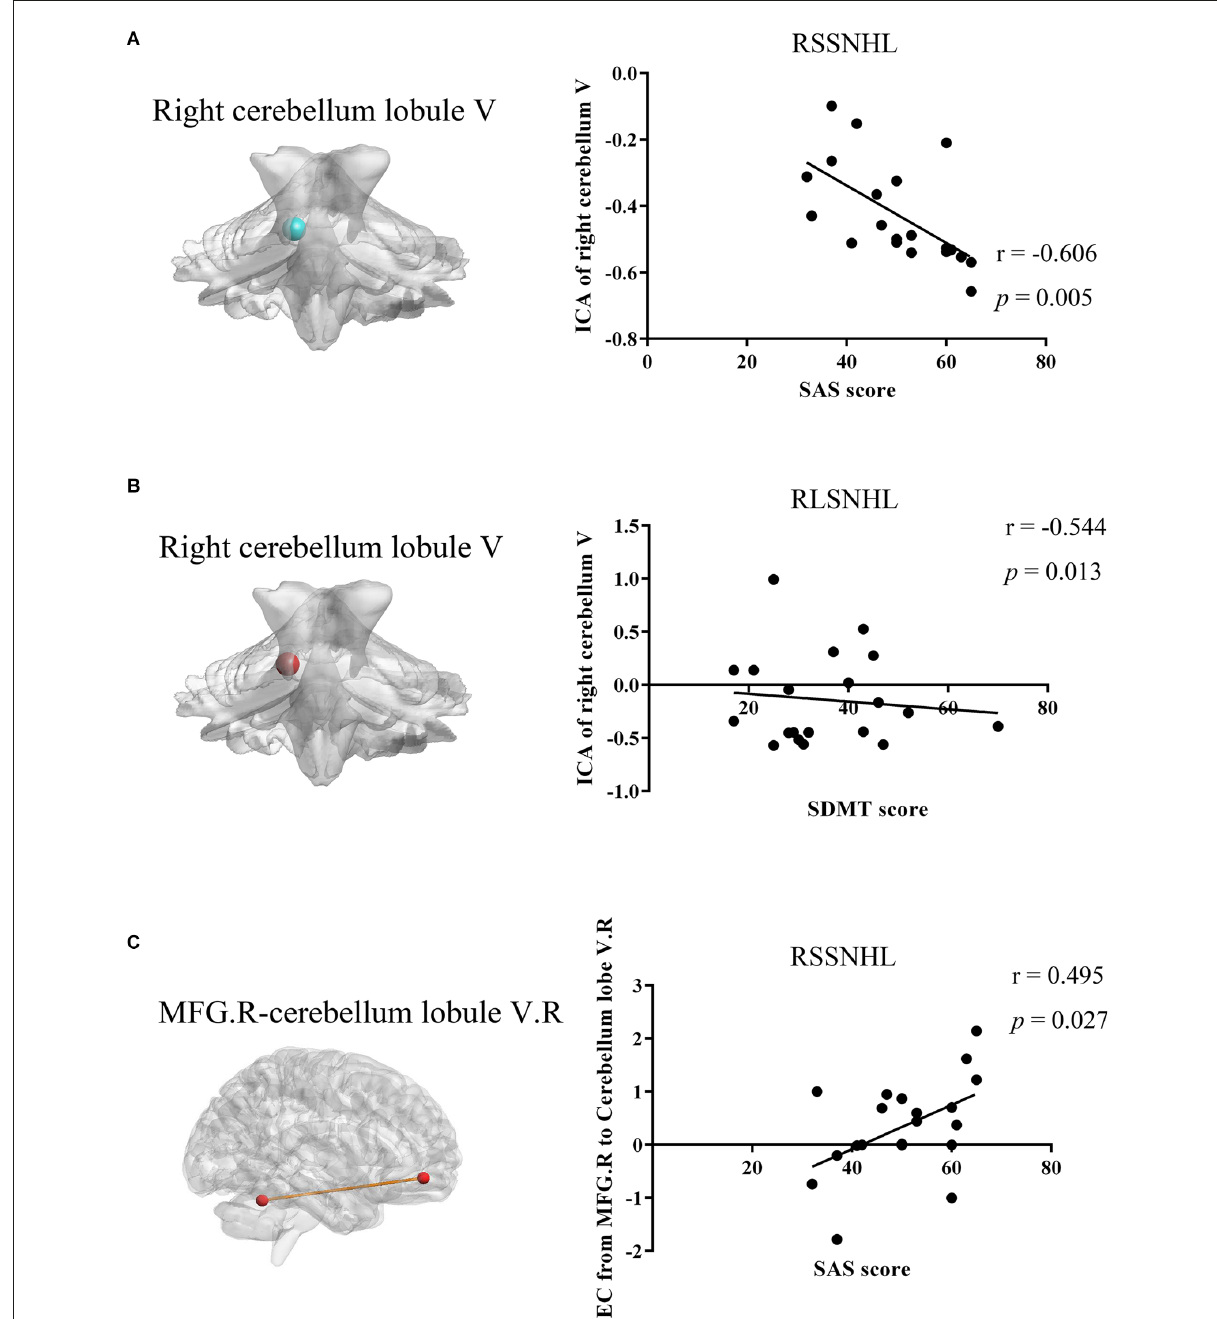
FIGURE4 Relationships between MRI imaging properties and clinical features in RSSNHL and RLSNHL. (A) Decreased functional connectivity between the right cerebellum lobule V and mean time series of cerebellar network in RSSNHL group was negatively correlated with SAS score ( r = − 0.606, p = 0.005). (B) Increased connections between the right cerebellum lobule V and mean time series of the cerebellar network in RLSNHL group showed negative correlation with SDMT performance ( r = − 0.544, p = 0.013). (C) Effective connectivity from right MFG to the right cerebellum lobule V could predict anxiety status in RSSNHL subjects ( r = 0.495, p = 0.027). MRI, magnetic resonance imaging; ICA, independent components analysis; SAS, self-rating anxiety scale; SDMT, Hamilton depression scale; MFG, middle frontal gyrus; RSSNHL, right sudden sensorineural hearing loss; RLSNHL, right long-term sensorineural hearing